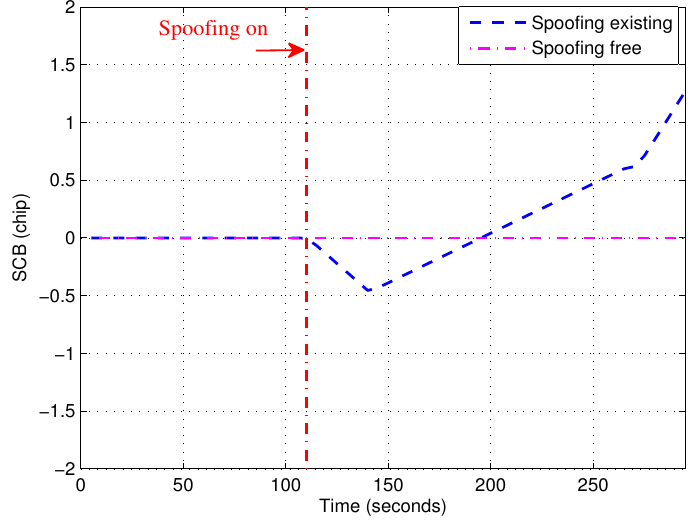
Figure 2. Theoretical S-curve-bias (SCB) curve with and without induced